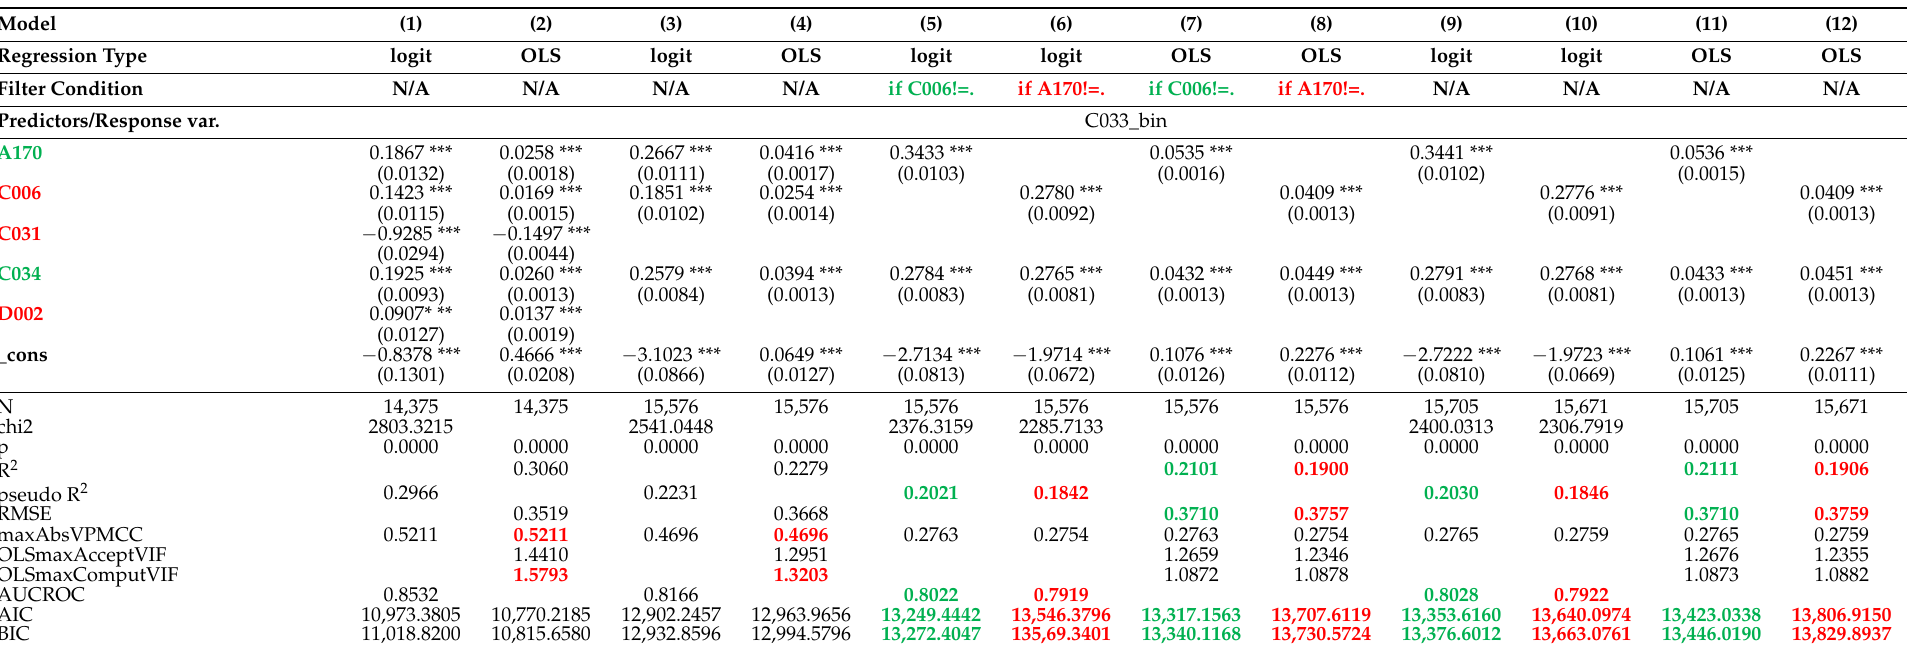
Table A4. Comparative regression models for predicting job satisfaction (C033_bin) after removing reverse causality and collinearity issues and performing additional